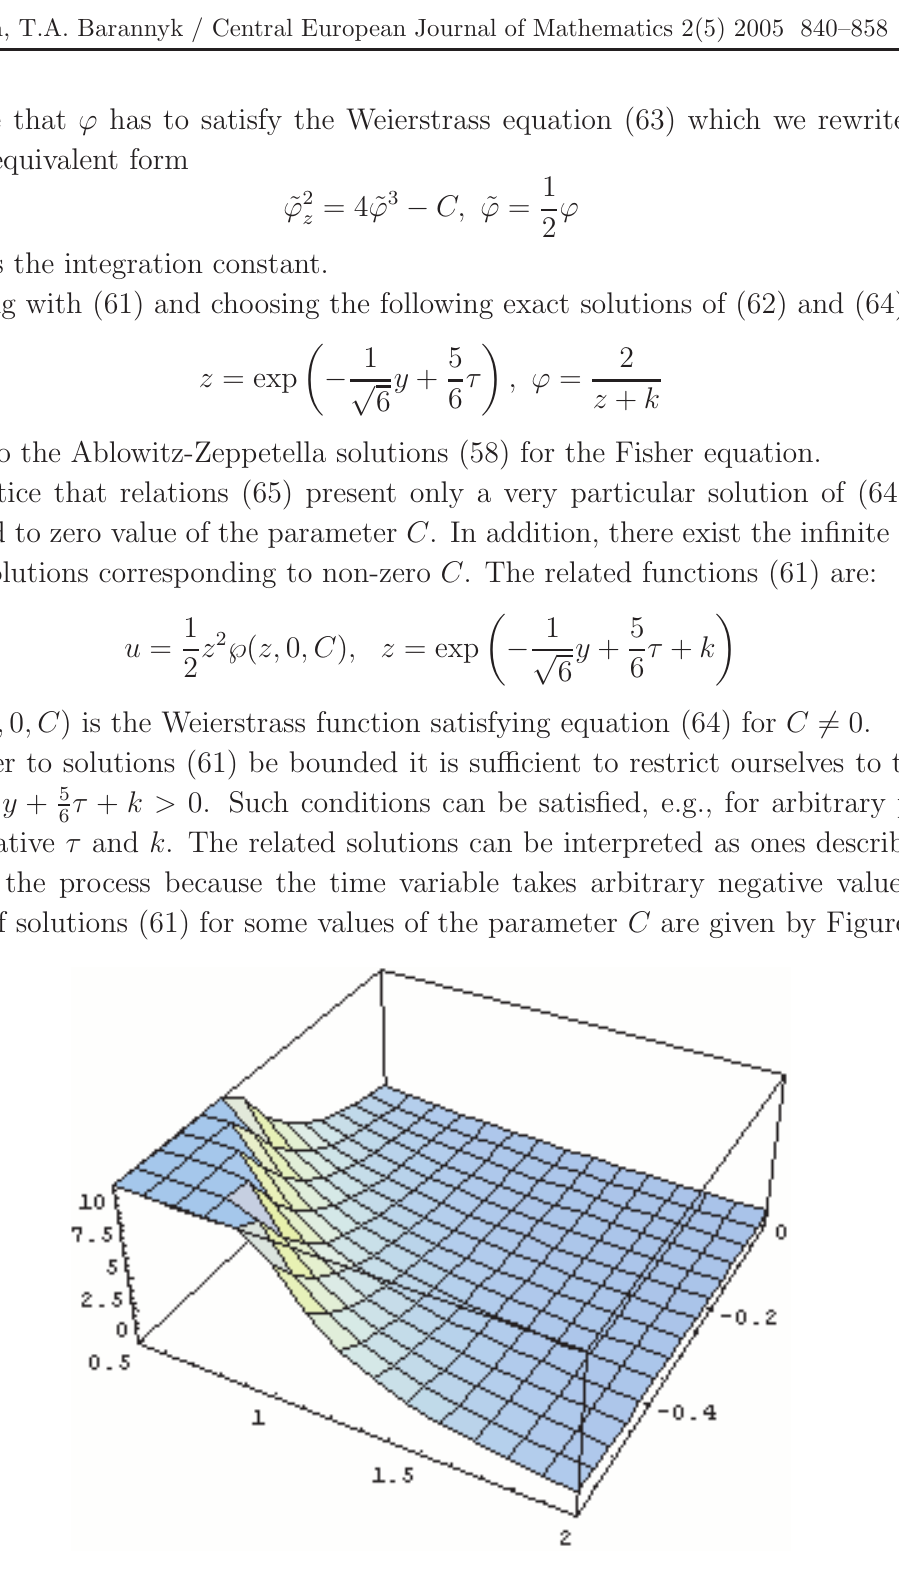
Fig. 5 Solution (66) with k = 0 , C = 10 2 for the Fisher equation